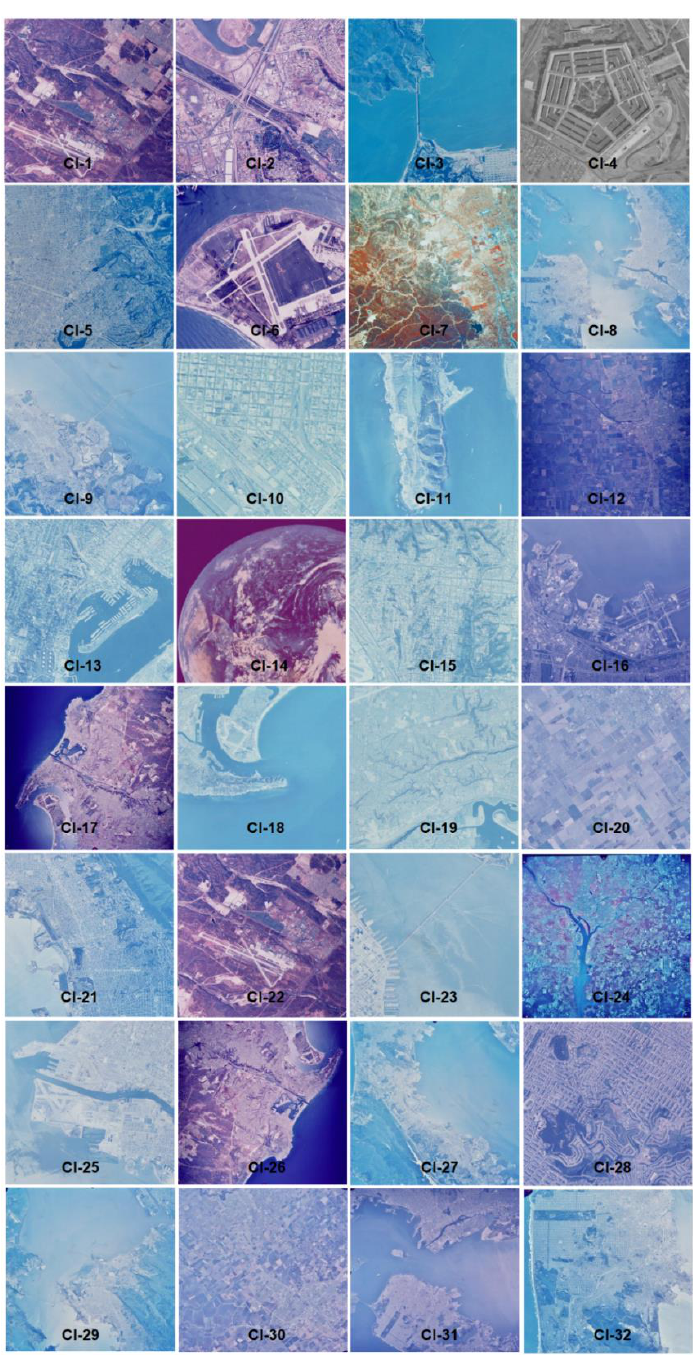
Figure 5. USC-SIPI Cover Images.